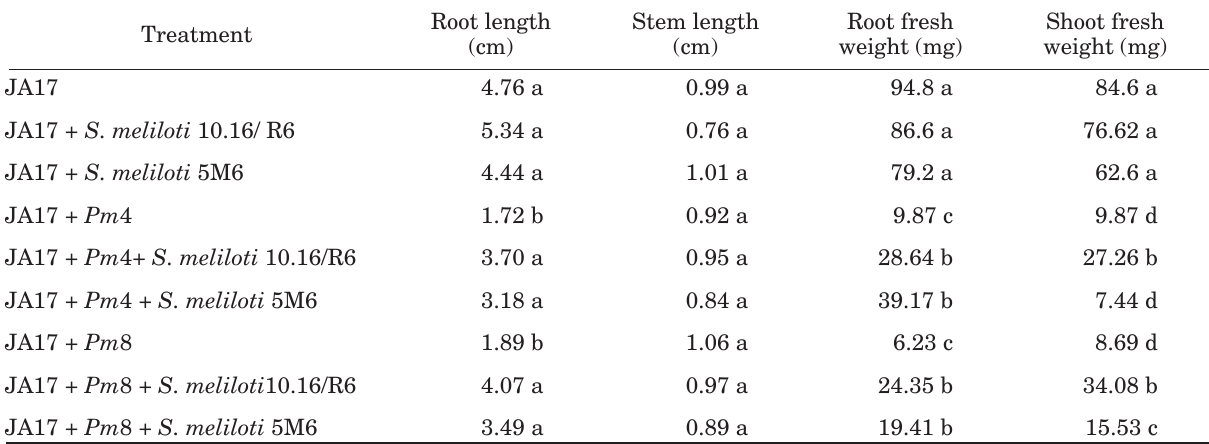
Table 2. Mean growth parameters of Medicago truncatula JA17 seedlings 21 days after inoculation with Phoma me– dicaginis strains Pm 4 and Pm 8 and co-inoculation with Sinorhizobium meliloti strains. Each value corresponds to an average of 15 replicates. Values in each column accompanied by different letters signi fi cantly different ( P <0.05) as indicated by Duncan’s multiple range test. Root length Stem length Root fresh Shoot fresh Treatment (cm) (cm) weight (mg) weight (mg)